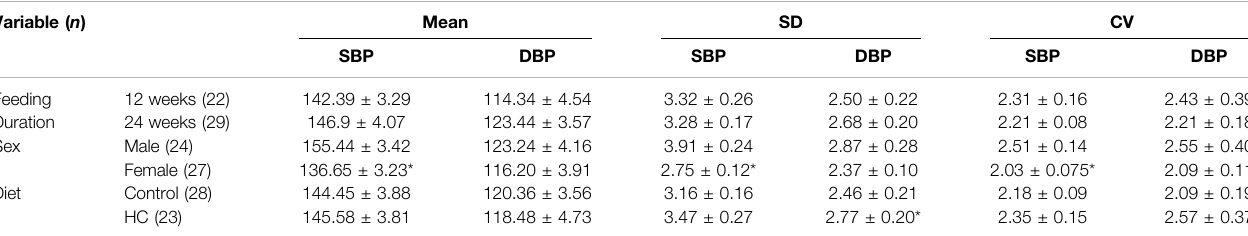
TABLE 1 | Univariate analysis of linear variability parameters of beat-to-beat systolic blood pressure(SBP) and diastolic blood pressure (DBP) time series across different rat groups. Statistical analysis was determined using t -test or Mann – Whitney U test based on the results of the Shapiro – Wilk test of normality. *denotes p < 0.05 for 12 weeks vs. 24 weeks, males vs. females, or control vs. HC. Variable ( n ) Mean SD